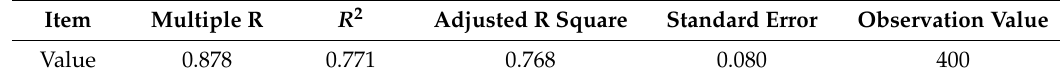
Table 5. Regression statistics.